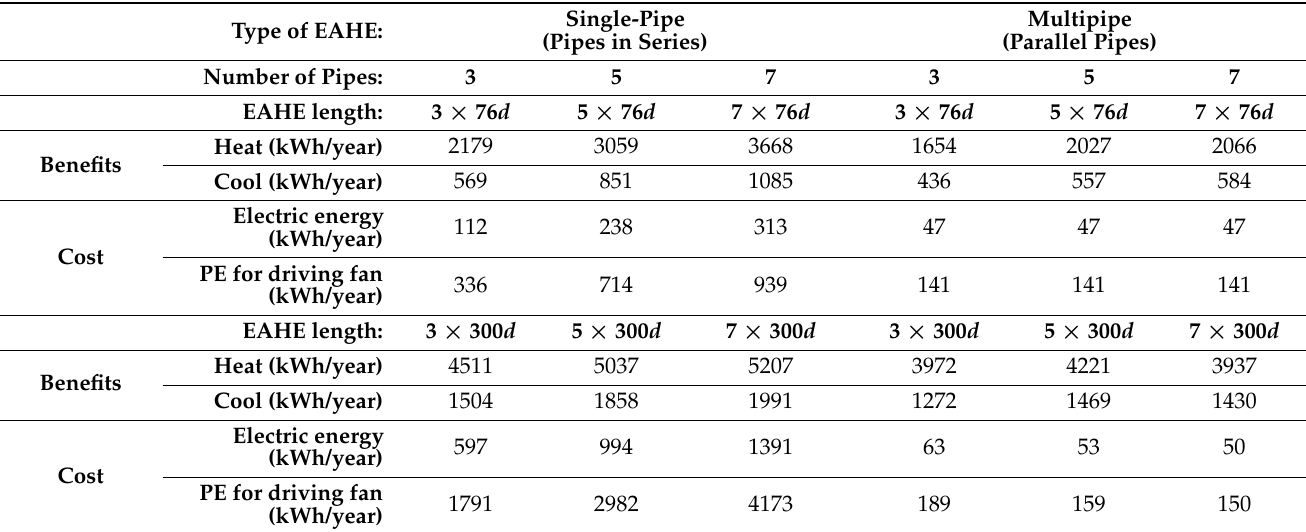
Table 6. Results of full-year energy calculation: benefits (heating and cooling) and costs (electric energy and primary energy usage PE) related to usage of single- and multipipe EAHEs, V = 600 m 3